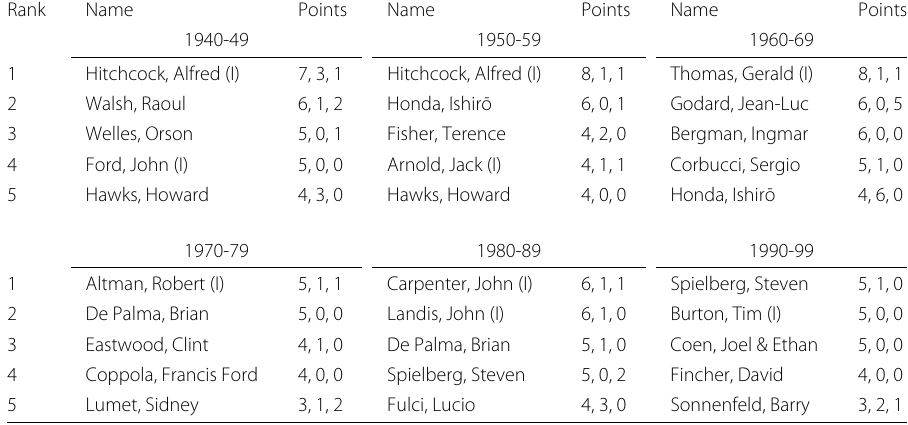
Table 5 Top 5 directors by decade, from 40’s to